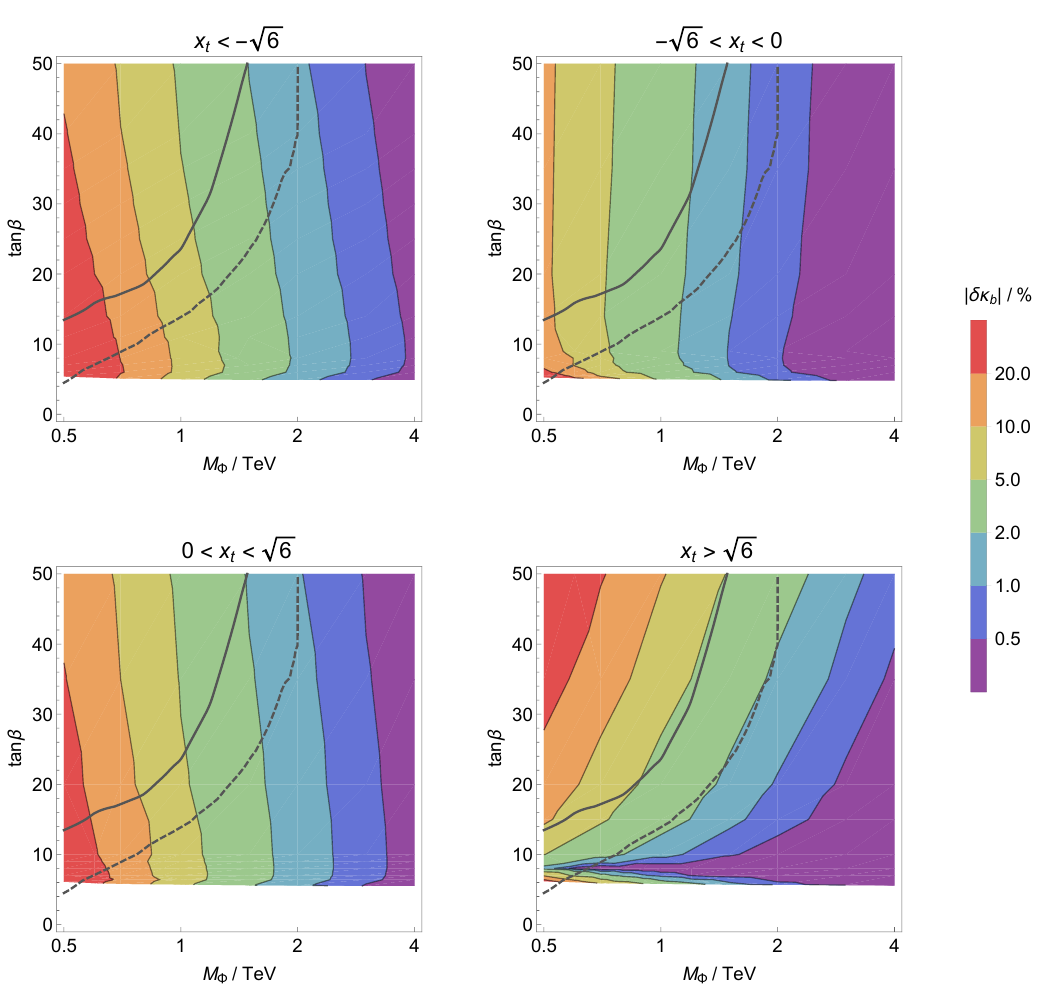
Figure 8 . Contours of j (cid:14)(cid:20) b j in the M (cid:8) -tan (cid:12) plane, for our benchmark scenario j M 3 j = 5 TeV, M s = 10 TeV, which will evade gluino and stop searches at the LHC. The Higgsino mass is de- termined by exact b - (cid:28) Yukawa uni(cid:12)cation, for which solutions exist for tan (cid:12) & 5. Dark solid and dashed curves represent current exclusion limit (95% CL) and projected high-luminosity reach (95% CL with 3 ab (cid:0) 1 at 14 TeV) from heavy Higgs searches in the di-tau channel at the LHC, reported assuming the m mod+ benchmark scenario. Future Higgs factories, with 0.5-1% projected precision h for the hb (cid:22) b coupling, will be able to probe much of the parameter space